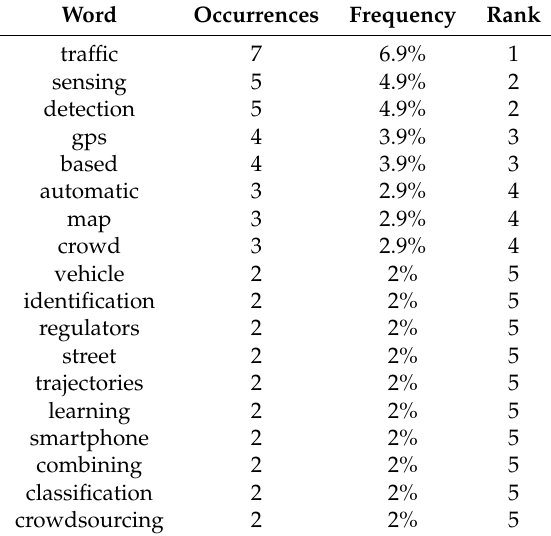
Table 9. Occurrences and frequency of the terms that are found in title text (all title as a single text) of the SLR selected articles (shown for occurrences greater than